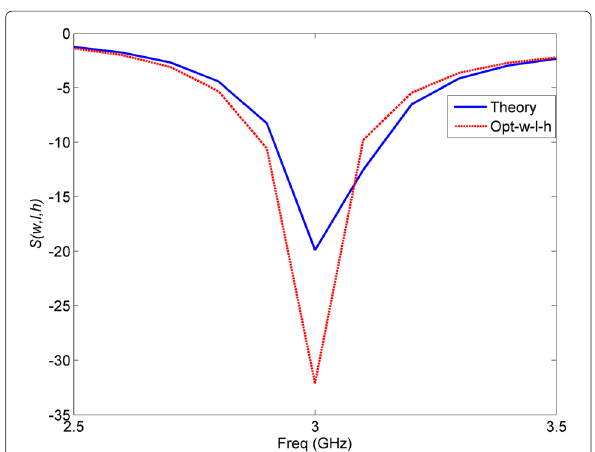
Fig. 4 Comparison of theoretical solution versus the solution through optimizing l by SZOA